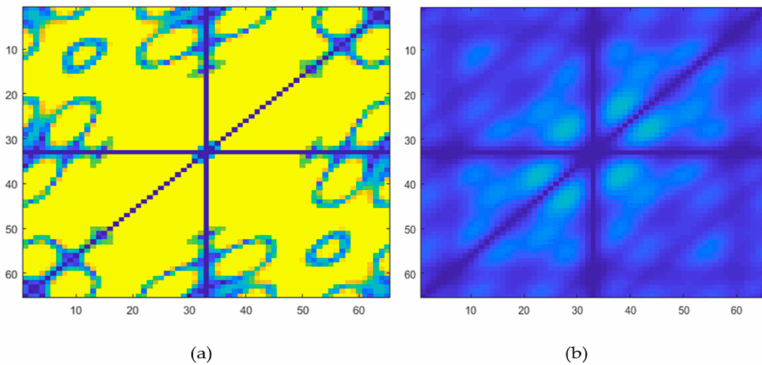
Figure 4. Bispectrum plots of ( a ) normal and ( b ) ASD classes (channel